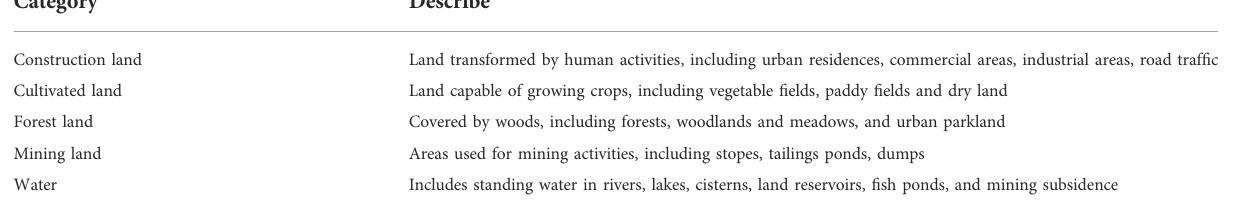
TABLE 2 Land use classi fi